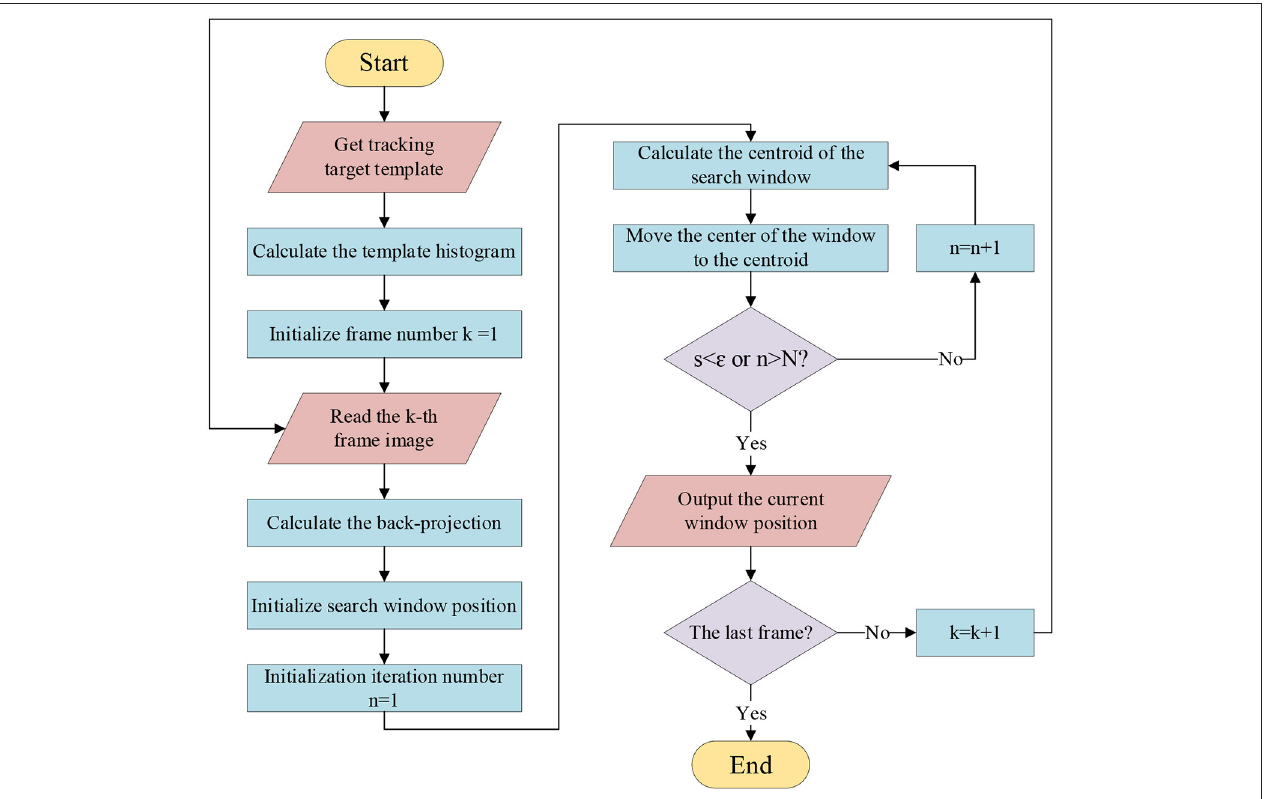
FIGURE 1 | Algorithm flow of the mean-shift using back